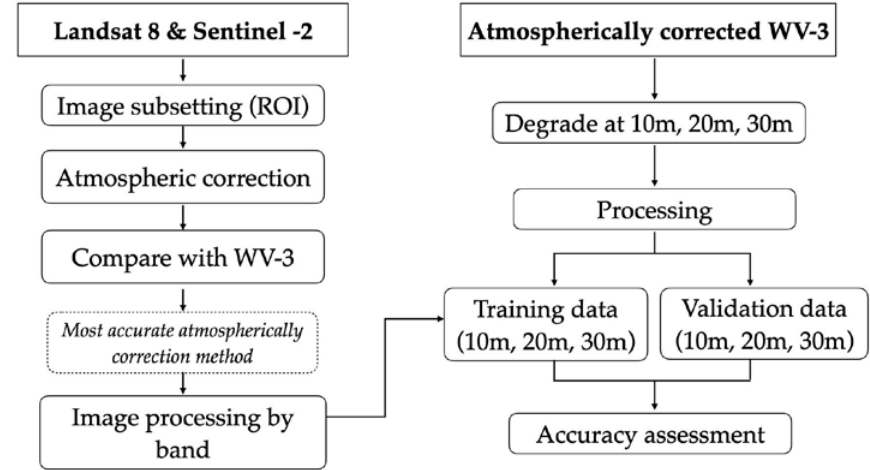
Figure 2. Chl a estimation workflow using S2, L8 and WV3 images.